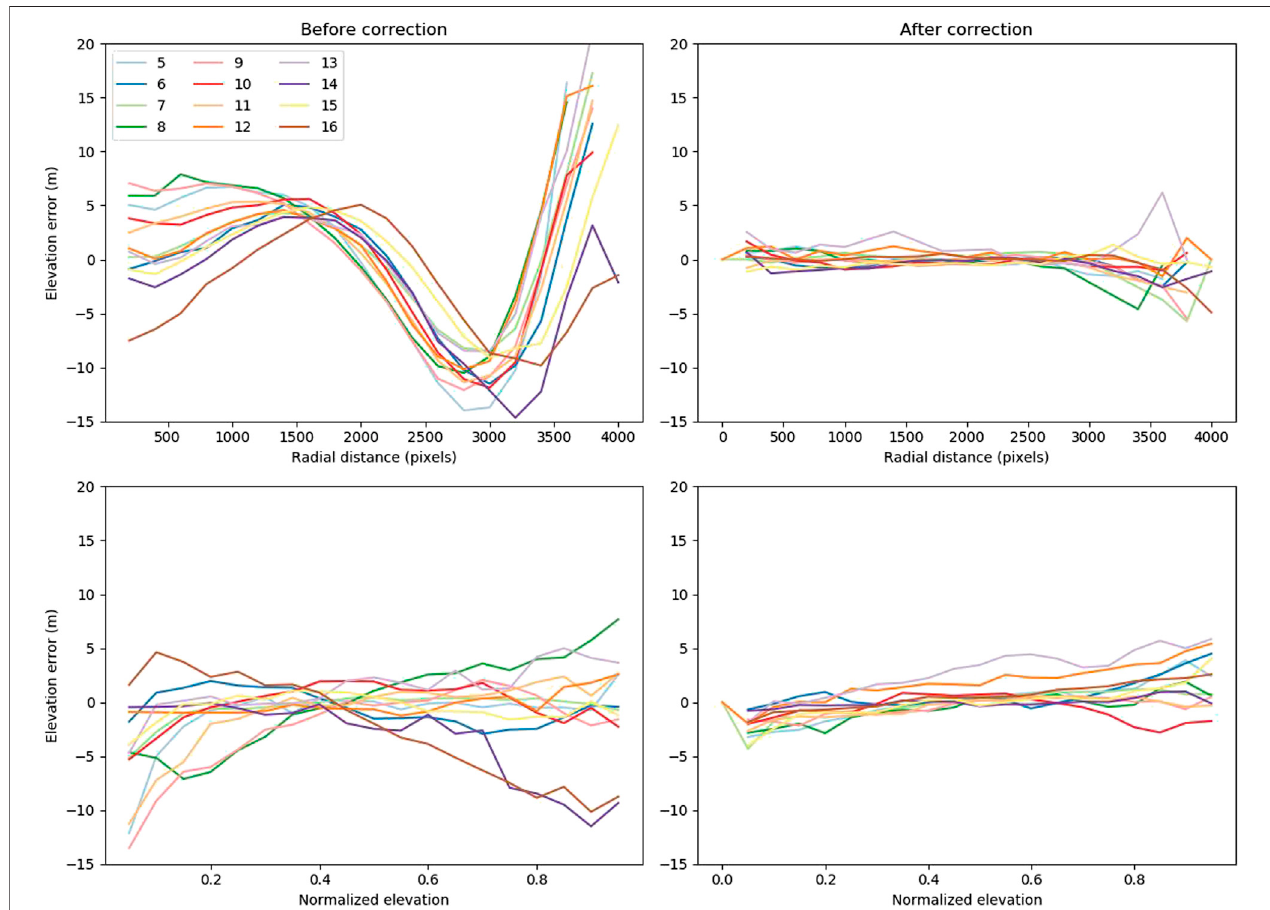
FIGURE 6 | Average elevation bias of all KH-9 MC DEMs as a function of the distance to the DEM center (pixel size 30 m), for each of the twelve KH-9 missions equipped with MC (A) when lens radial distortion is neglected and (B) after correcting for lens radial distortion. Average elevation bias as a function of the normalized elevation ([ z − min ( z )] / [ max ( z ) − min ( z )]) (C) when assuming the documented focal length of 304.8 mm and (D) using the estimated focal length for each